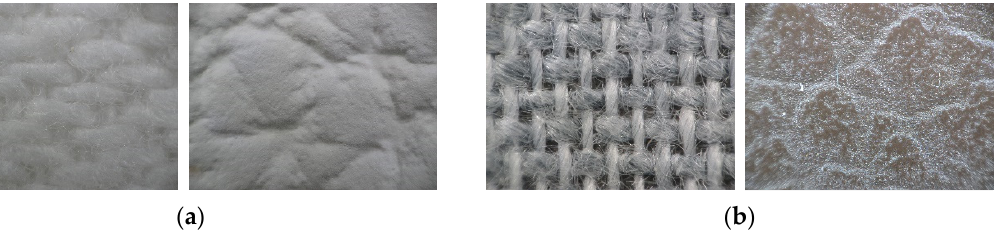
Figure 1. Types of tested faux leathers (150× magnification); left back side, right top side ( a ) PU faux leather fabric, ( b ) PVC faux leather fabric.